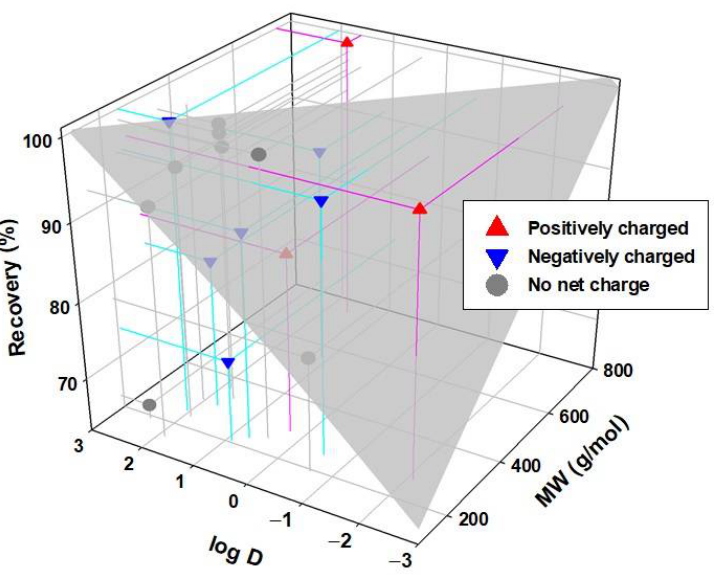
Figure 11. Recovery in the FS of the different CECs after the FO processes against the molecular weight and log D.